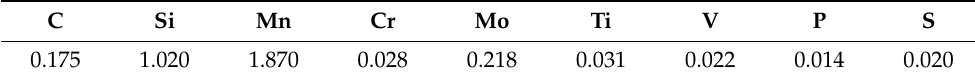
Table 1. Chemical composition of the tested steel